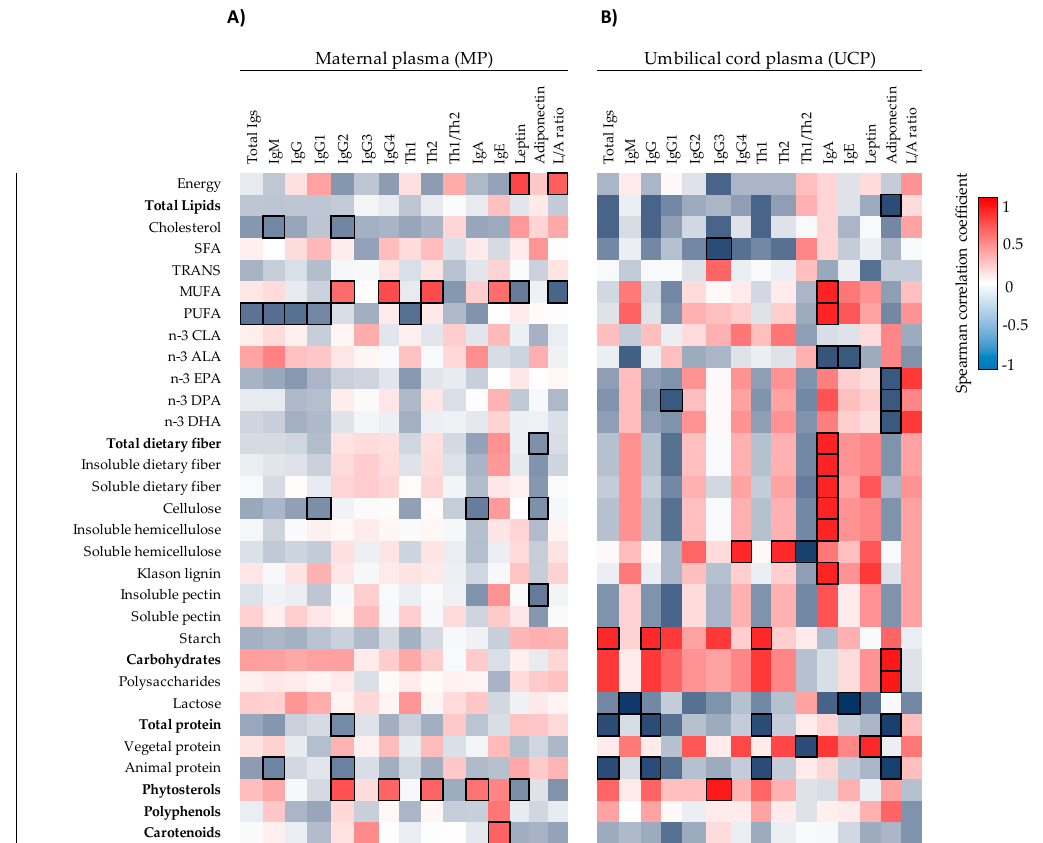
Figure 5. Correlations between Ig and adipokine composition present in MP ( A ) ( n = 13) and UCP ( B ) ( n = 6) with the maternal dietary intakes. The Spearman correlation coefficient is represented in the heat map following the color in the legend. Bold frames represent correlations with statistical significance ( p < 0.05). MP, maternal plasma; UCP, umbilical cord plasma; L/A ratio, Leptin/Adiponectin ratio. IgG1, IgG2 and IgG3 (Igs associated with Th1 response); IgG4 (Ig associated with Th2 response) [30,31].